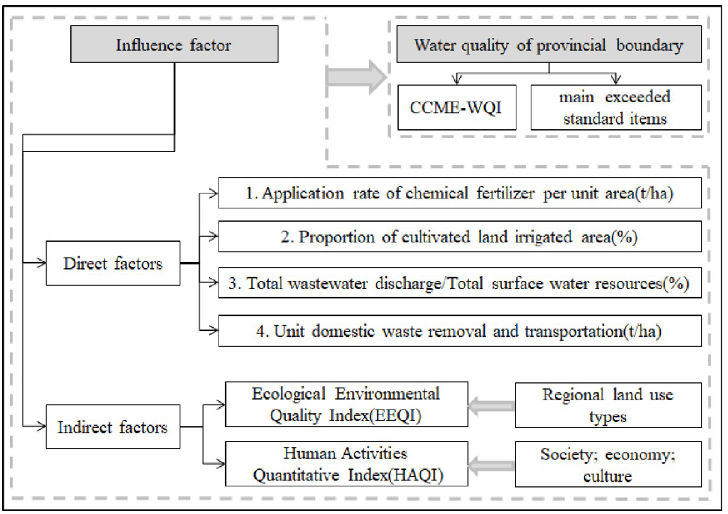
Fig 2. Framework for analysis of factors influencing the quality of provincial boundary